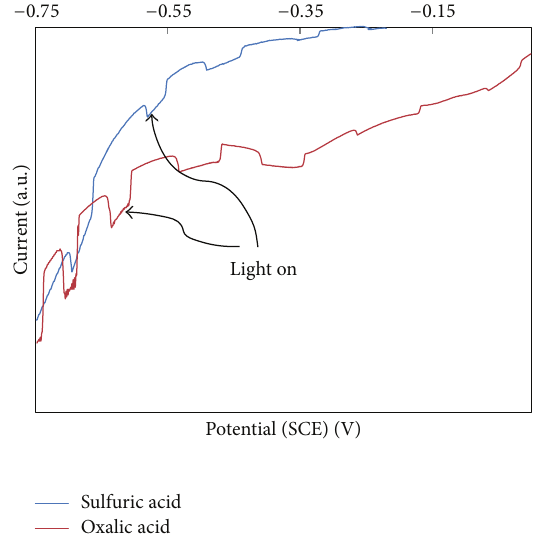
Figure 5: A comparison of current potential behavior/photoelec- trochemical response of CZTS thin film in oxalic acid and sulfuric acid solution.